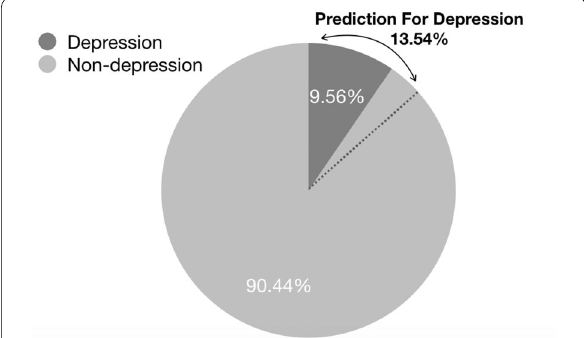
Fig. 5 Coverage in correct classification of